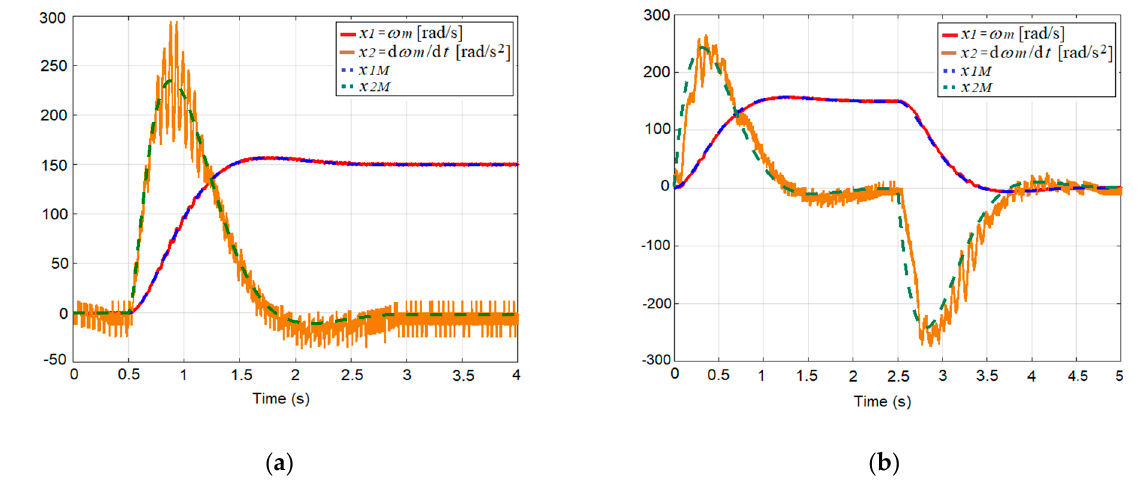
Figure 17. Motor starting at: ( a ) α = 5 and k T = 3 [0.0031 0.0019 0.00038]; ( b ) α = 5 and k T = [0.0031 0.0019 0.00038].